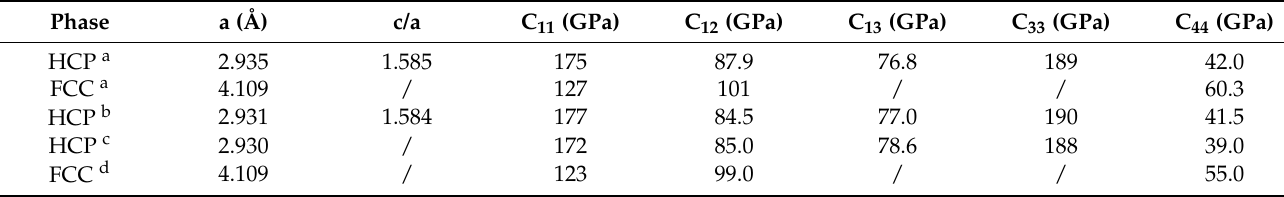
Table 1. Comparison of DFT